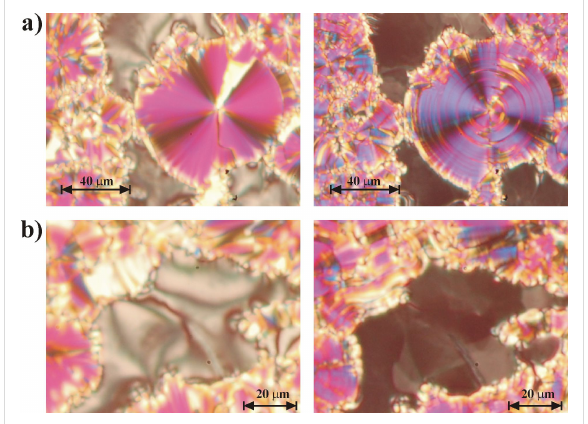
Figure 8: Textures of the pure compound PhP16 on cooling. Left: SmC phase at 96.8 °C Right: same positions in the SmF phase at 82.7 °C. (a) In the upper part a fan-shaped texture is shown, while (b) in the lower part a homeotropic texture can be seen.